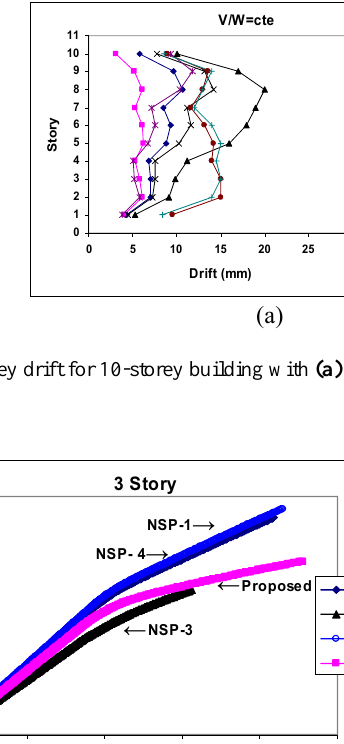
Figure 14. Base shear vs. roof drift response using different lateral load profiles for 3-storey building